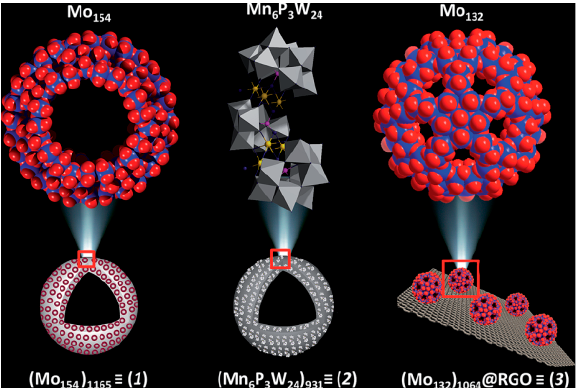
Figure 8. The structures of {Mo 154 }, {Mn 6 P 3 W 24 }, and {Mo 132 } POM macroions catalysts. Color code: Mo, red ball; O, blue ball; Mn, yellow ball; P, pink ball; WO 6 octahedron, grey. Reprinted with